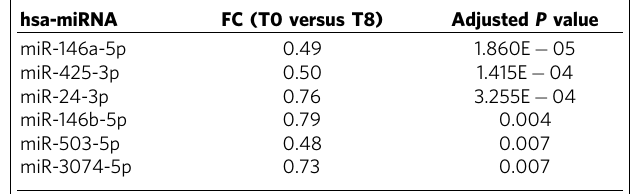
Table 2 | Placebo